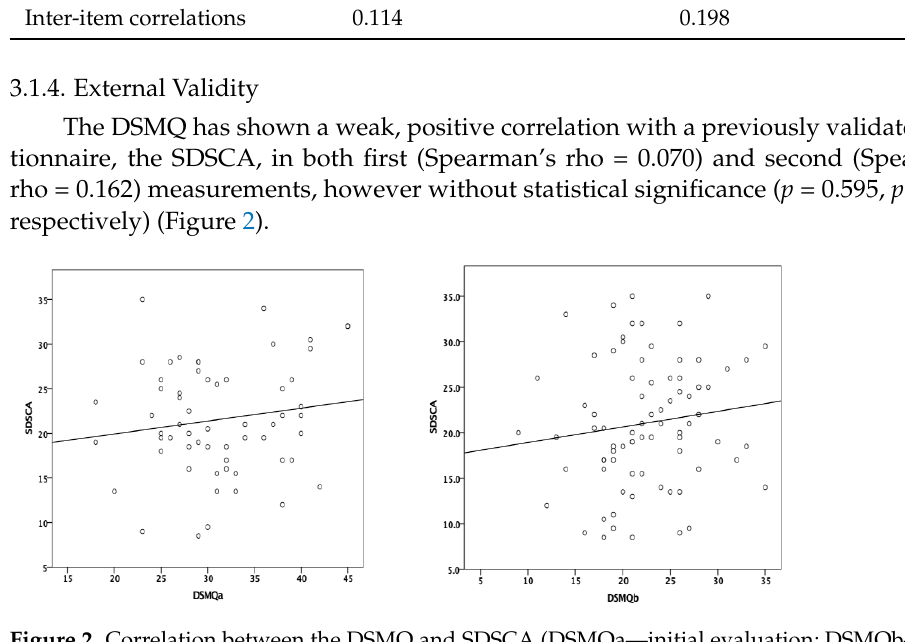
Figure 2. Correlation between the DSMQ and SDSCA (DSMQa—initial evaluation; DSMQb—follow-up evaluation).